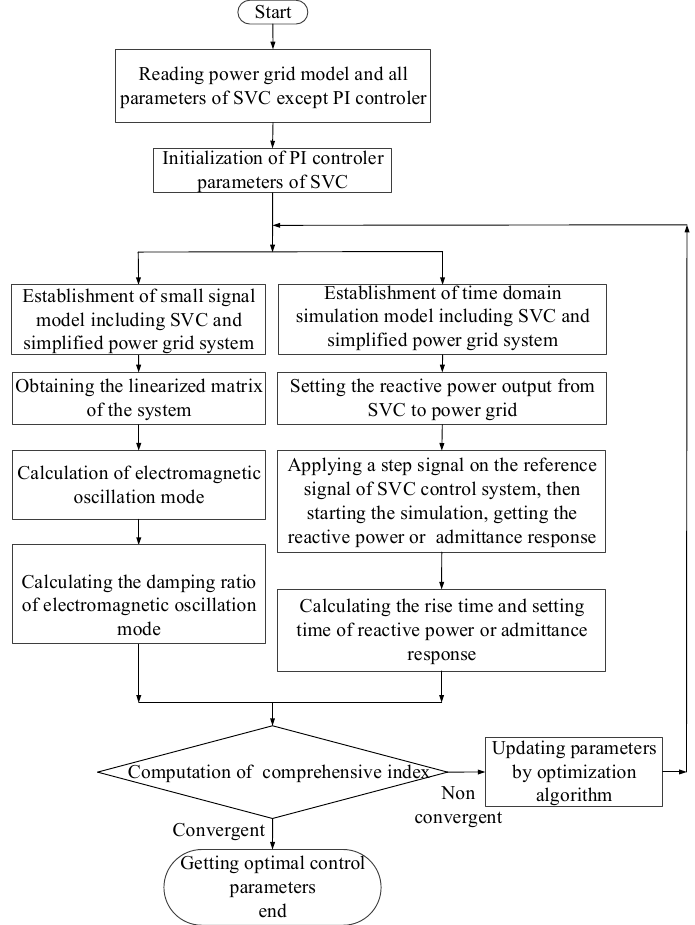
Figure 11. Optimization procedure of SVC PI parameters.